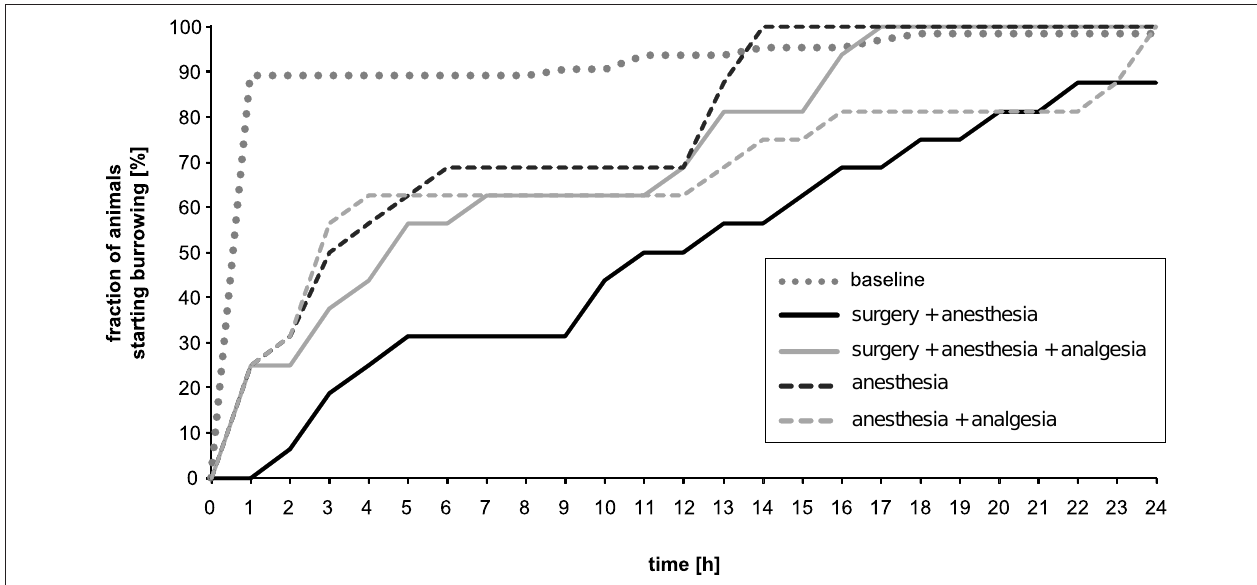
Figure 3 | Percentage of mice/hour that started burrowing at baseline vs. experimental conditions. Healthy mice started burrowing immediately, mostly within 1 h (baseline). Between-treatment differences were greatest between hours 7 and